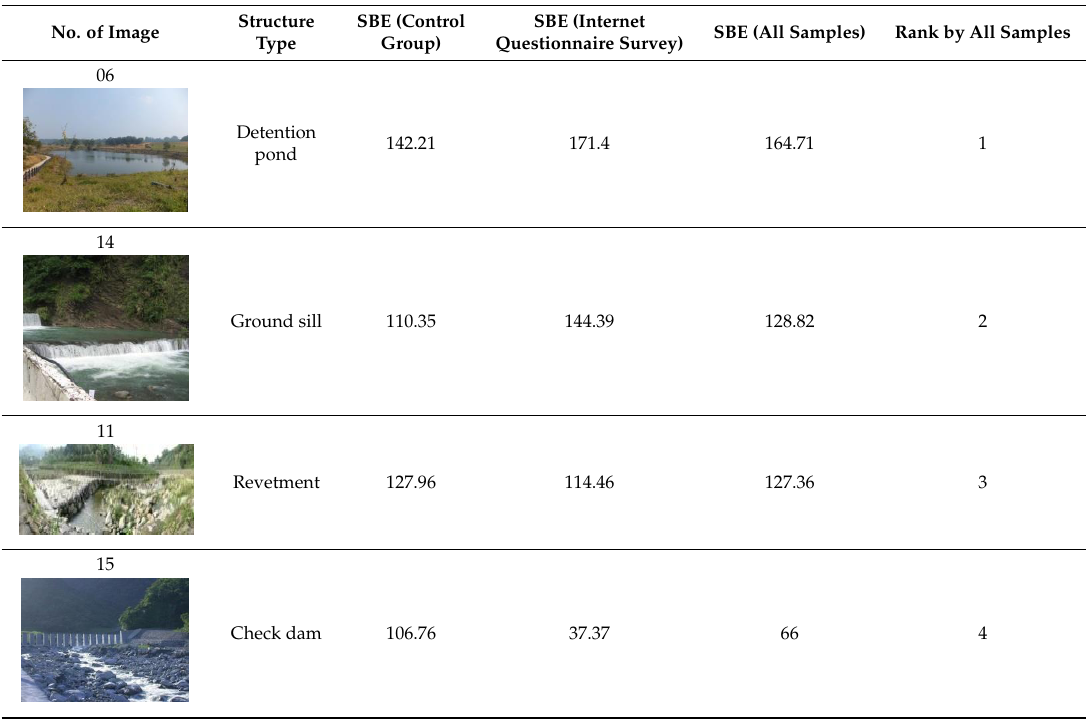
Table 4. Landscape assessment results of 16 images.